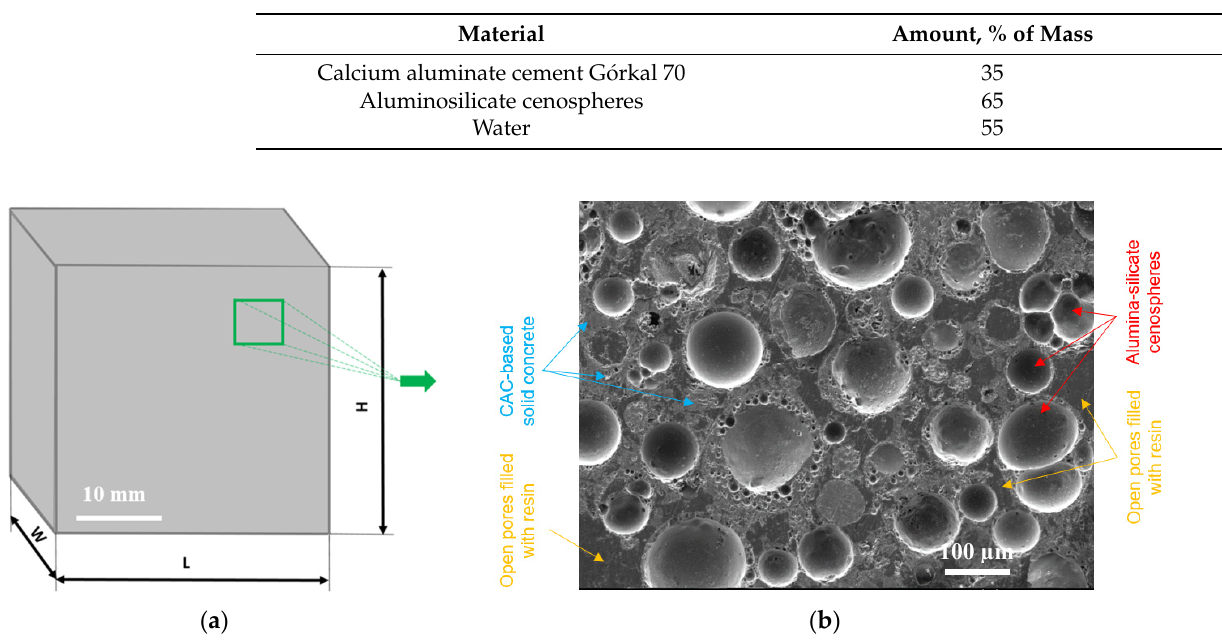
Figure 2. XRD difractogram of the aluminosilicate cenospheres (M-mullite). Table 1. The proportion of materials in the ALRC. Material Amount, % of Mass